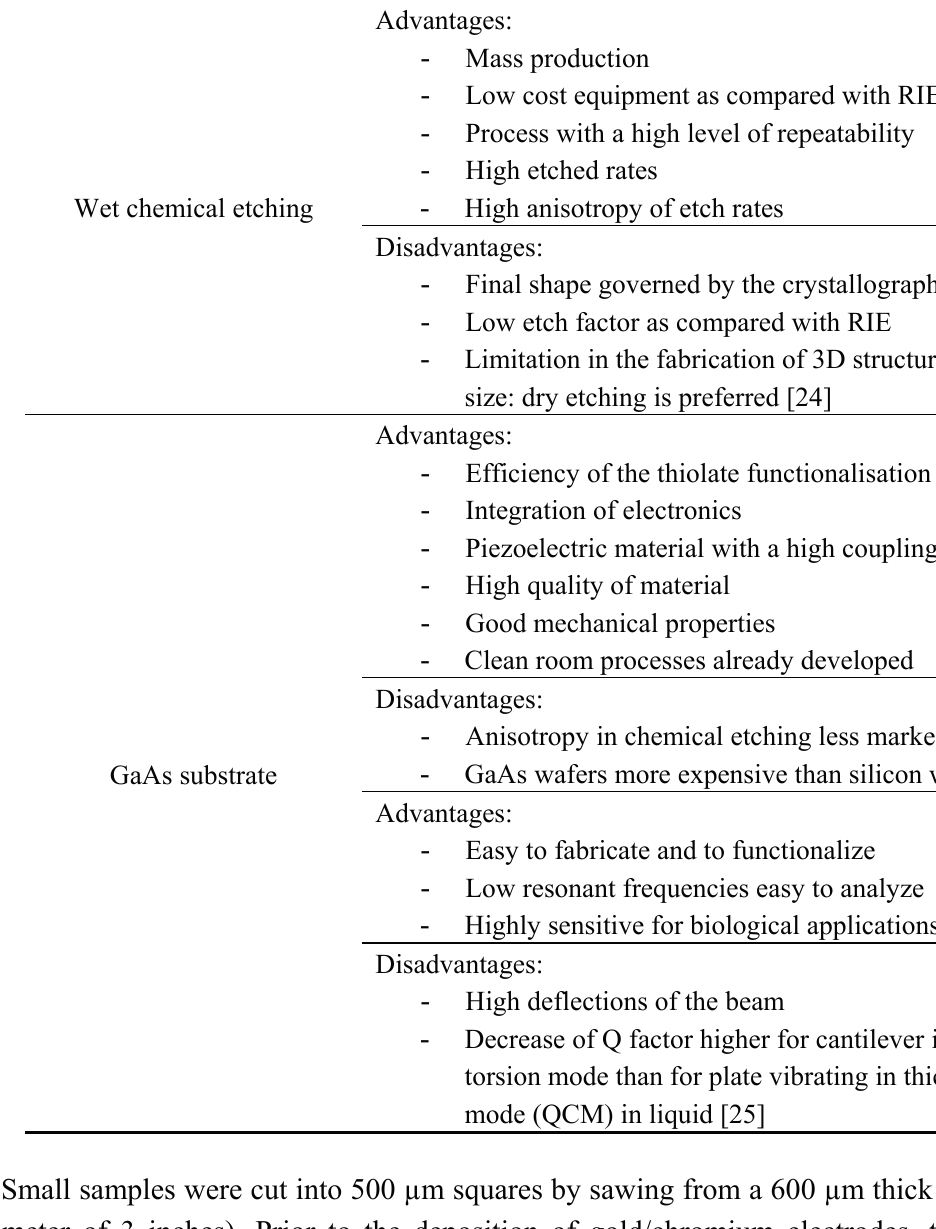
Table 1. Advantages and disadvantages of GaAs wet chemical etching of cantilevers.